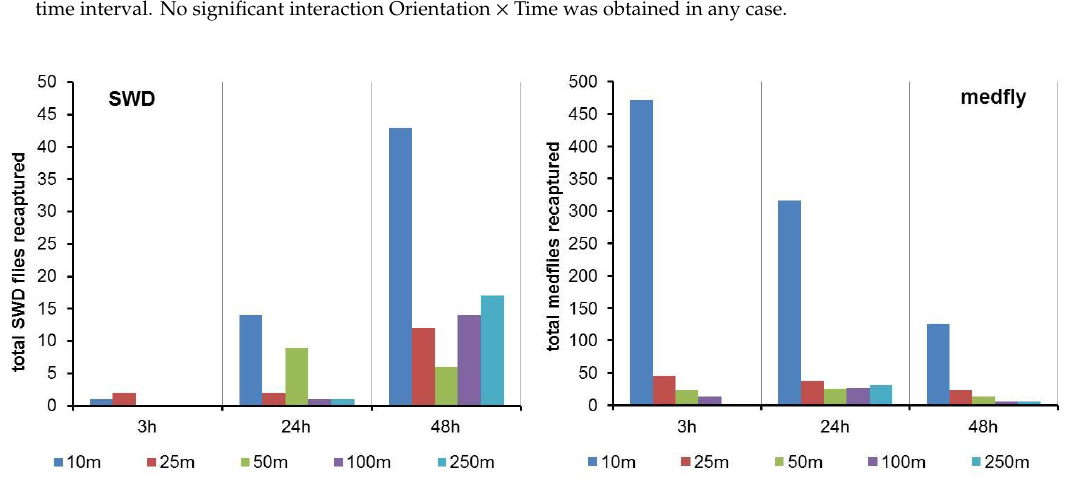
Figure 3. Total number of recaptured flies (left: D. suzukii (SWD); right: C. capitata (medfly)) at each sampling interval and at different distances from the release point during the three autumn 2015 trials.